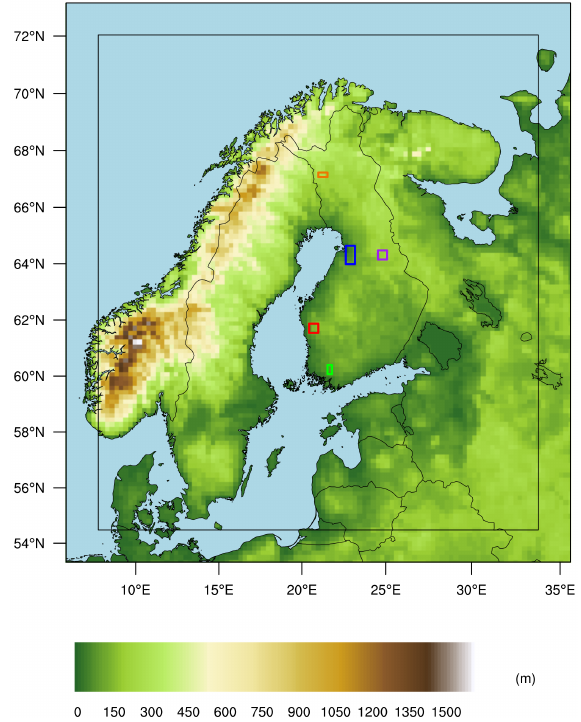
Figure 1. Orography of the model domain and the five selected sub- regions (subregion1 – blue; subregion2 – red; subregion3 – purple; subregion4 – green; subregion5 – orange). The inner black frame shows the extent of the relaxation zone from the outer boundary, i.e. the eight outer-most grid boxes in each direction of the model